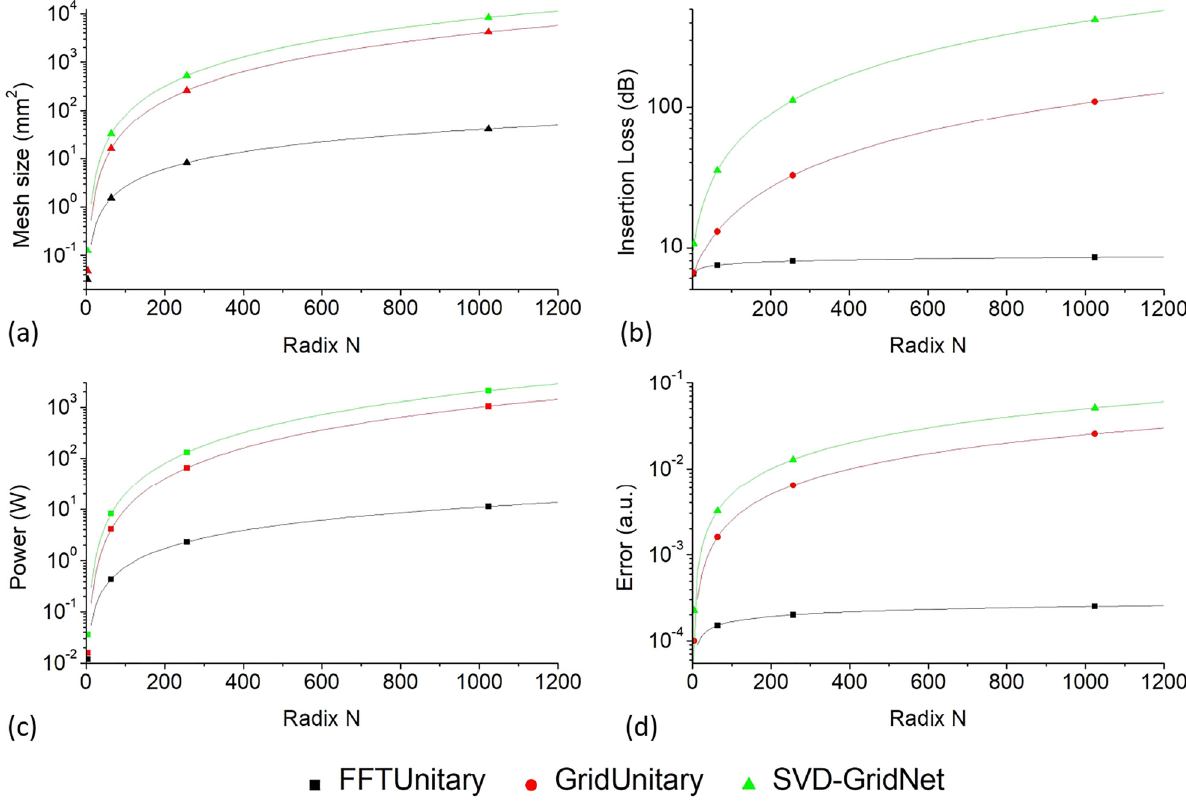
Figure 9: Comparison of the (a) mesh size, (b) insertion loss, (c) power consumption, (d) encoding error, among the pseudo-real-value nonuniversalFFTUnitarymesh(black)anduniversalGridUnitarymesh(red)aswellasconventionalSVD-GridNetmesh(green)asthefunctions of the radix N